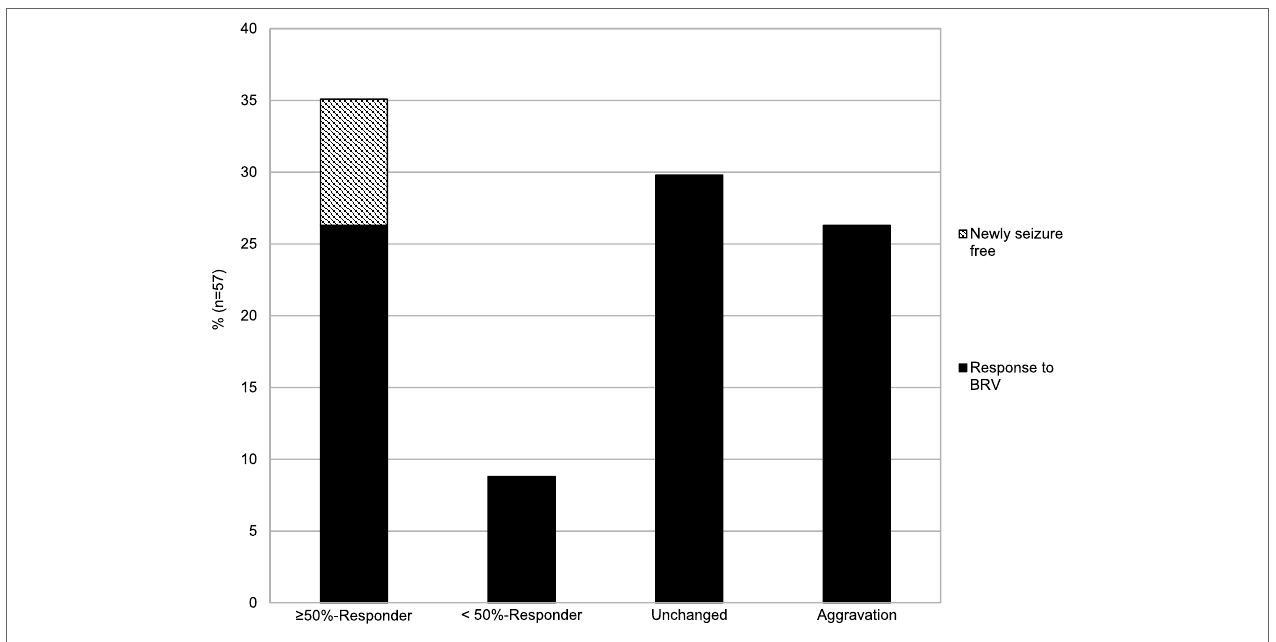
FigUre 1 | Change in seizure frequency after initiation of BRV